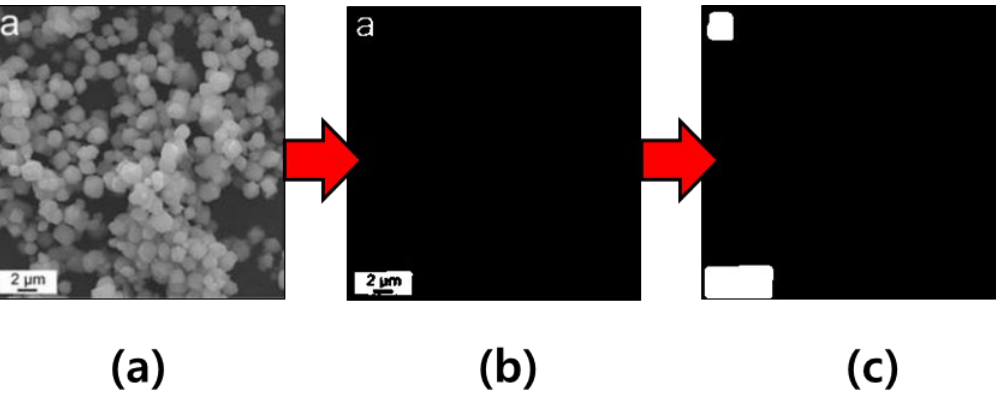
Figure 4. Processing sequence in regard to generating a threshold-based mask from the example of a microscopic image (reprinted with permission from Ref. [40]. Copyright (2021) Elsevier): ( a ) represents the input image; ( b ) represents the intermediate image in the context of threshold-based masking; and ( c ) represents the final image.